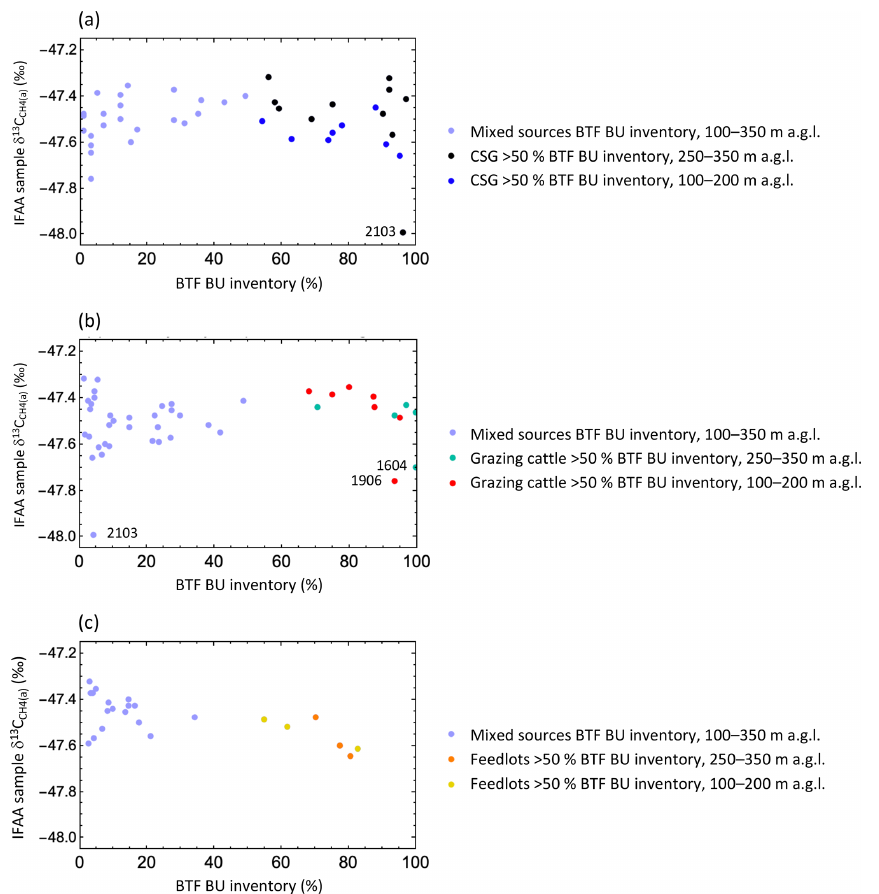
(‰) versus percentage of BTF BU inventory emissions of the source categories indicated in the figure Figure 4. IFAA sample δ 13 C CH 4(a) titles (%). (a) BTF BU inventories with CSG CH 4 contributions; IFAA sample 2103 was excluded from the Keeling modelling set. (b)